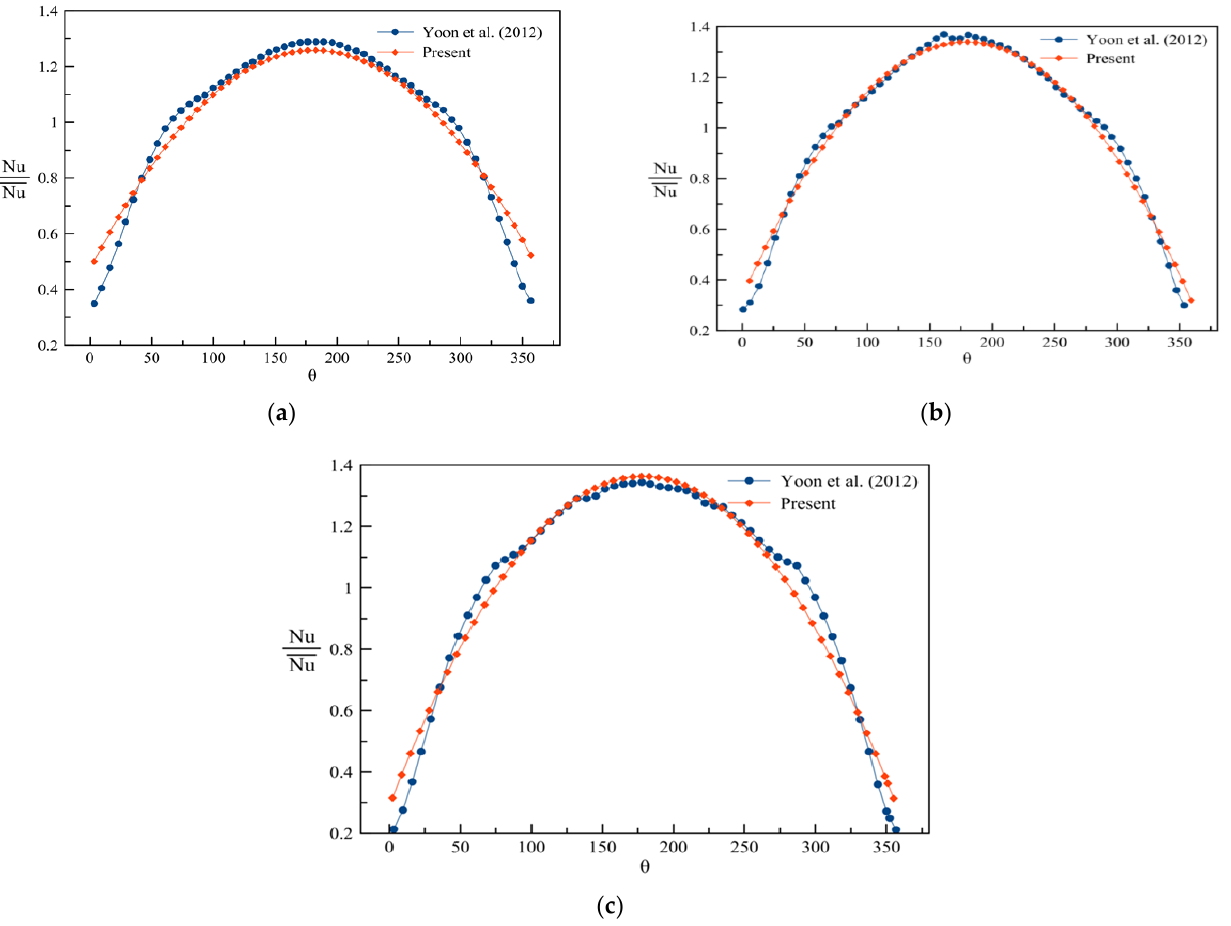
Figure 5. Local Nusselt number distribution along the circumference of the tube wall: ( a ) d/D = Local Nusselt number distribution along the circumference of the tube wall: 0.02078, ( b ) d/D = 0.04167 and ( c ) d/D = 0.08333. ( a ) d/D = 0.02078, ( b ) d/D = 0.04167 and ( c ) d/D =